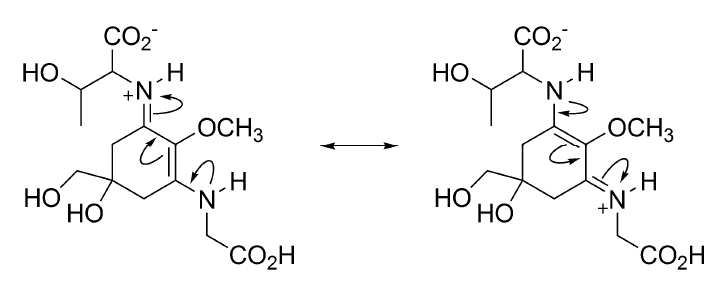
Figure 3. Resonance structure of protonated